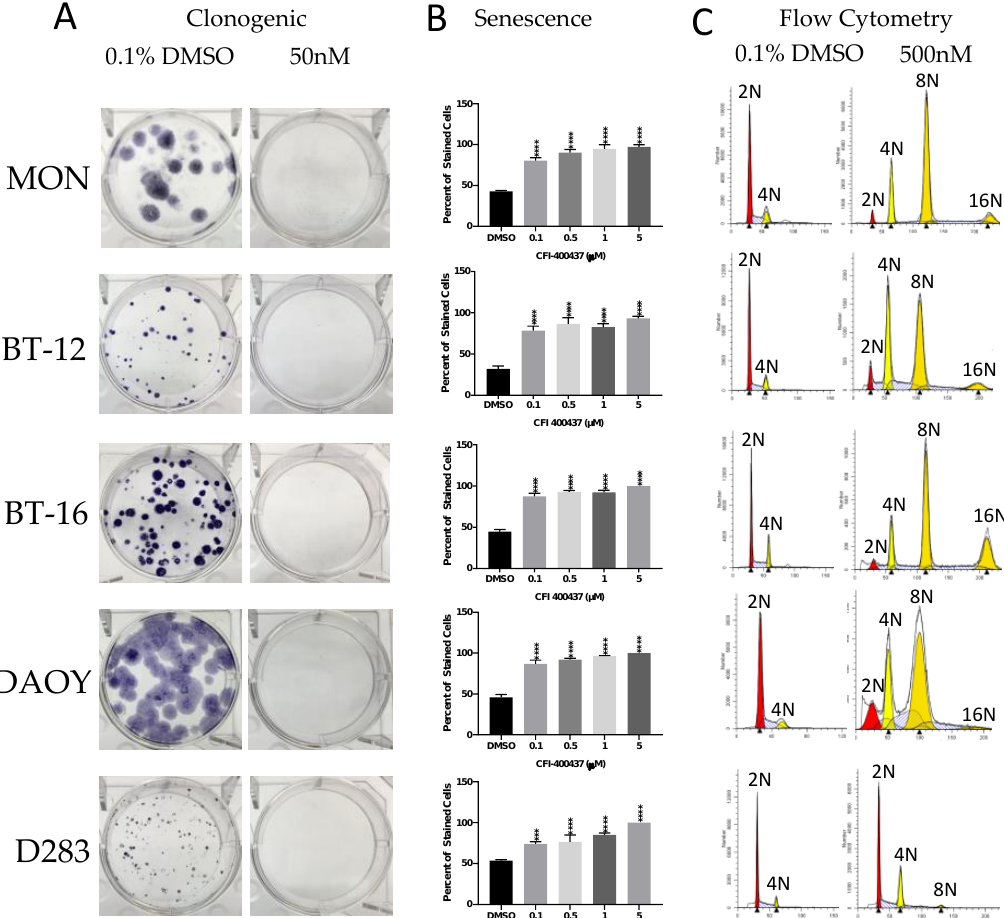
Figure 4. Phenotypic evaluation of CFI-400437 in multiple cells lines. ( A ) Clonogenic - colony formation assay of RT and MB cells treated with 50nM CFI-400437 reveals complete inhibition of colony formation in all cell lines. ( B ) Beta-galactosidase assay shows induction of cell senescence when treated with CFI-400437 in all cell lines (*** p < 0.001 and **** p < 0.0001, one-way ANOVA). ( C ) Cell cycle analysis reveals the induction of polyploidy with 500 nM CFI-400437.